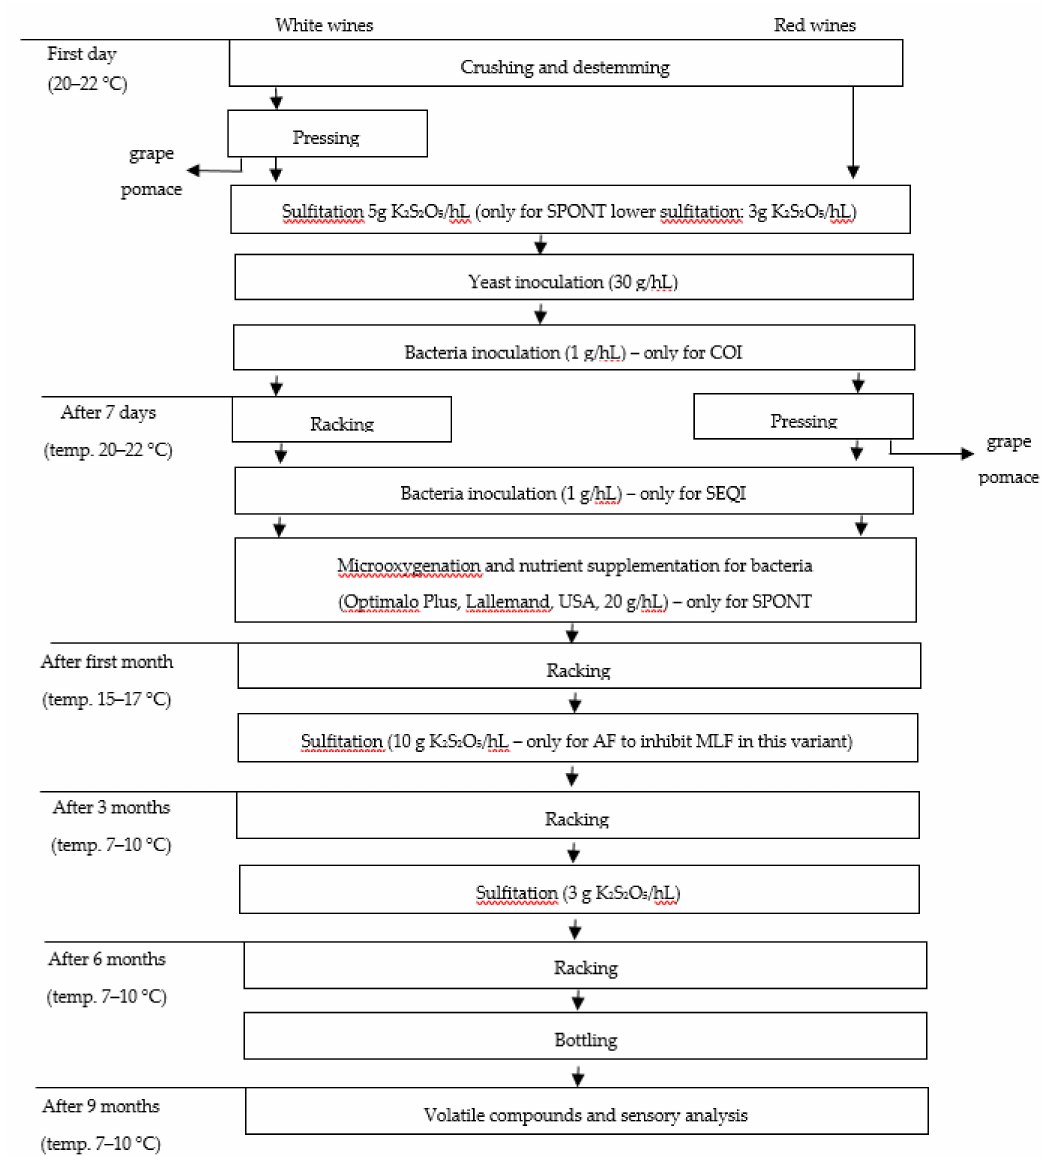
Figure 2. Flowchart of white and red wine production